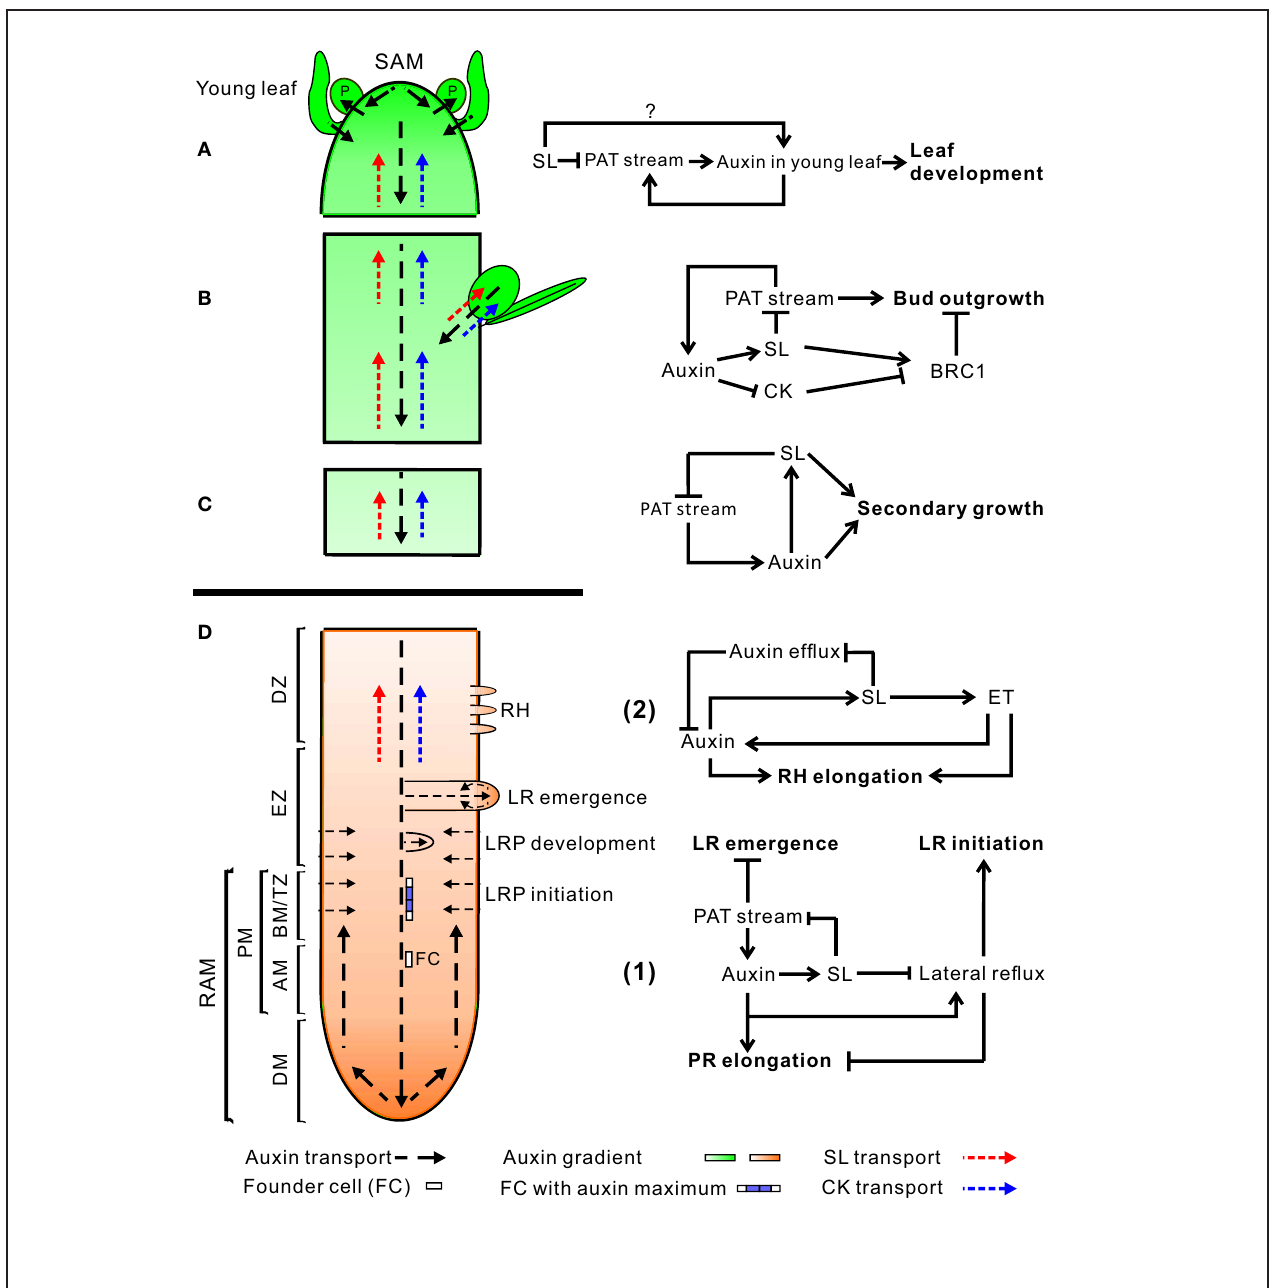
FIGURE 2 | An overview of auxin, SL, and CK transport within the plant (left) and hormone interactions during the regulation of shoot and root development (right). Auxin, strigolactone (SL), and cytokinin (CK) transport are represented by black, red, and blue dotted line, respectively. For hormone interactions (right), arrows represent promotion, while flat-ended lines indicate inhibition. (A) Auxin, produced in the shoot apical meristem (SAM) and young leaves, is transported basipetally through the stem in the polar auxin transport (PAT) stream toward the root apical meristem (RAM). Here, but probably also throughout the entire vasculature of the plant, it positively regulates SL biosynthesis (Hayward et al., 2009). As shown by GR24 feeding experiments, SLs transported through the xylem from the root to the shoot down-regulate the free auxin level in young leafs in a MAX2-dependent manner hereby controlling their development (Ruyter-Spira et al., 2011). SLs in